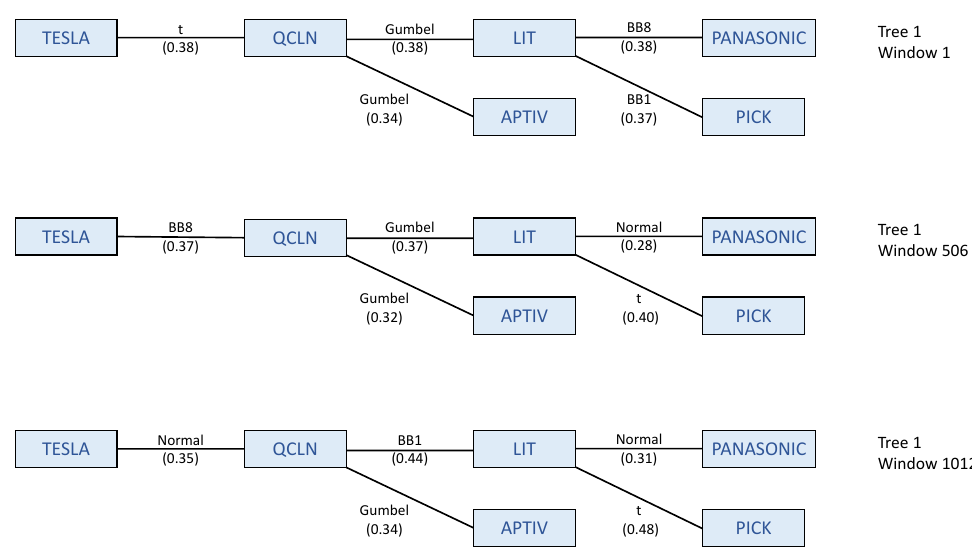
Figure 4. Trees T 1 of R-vines from windows number 1 (first), 506 (middle) and 1012 (last). Note: Numbers in parentheses are Kendall’s rank correlation correlation coefficients (Kendall’s τ